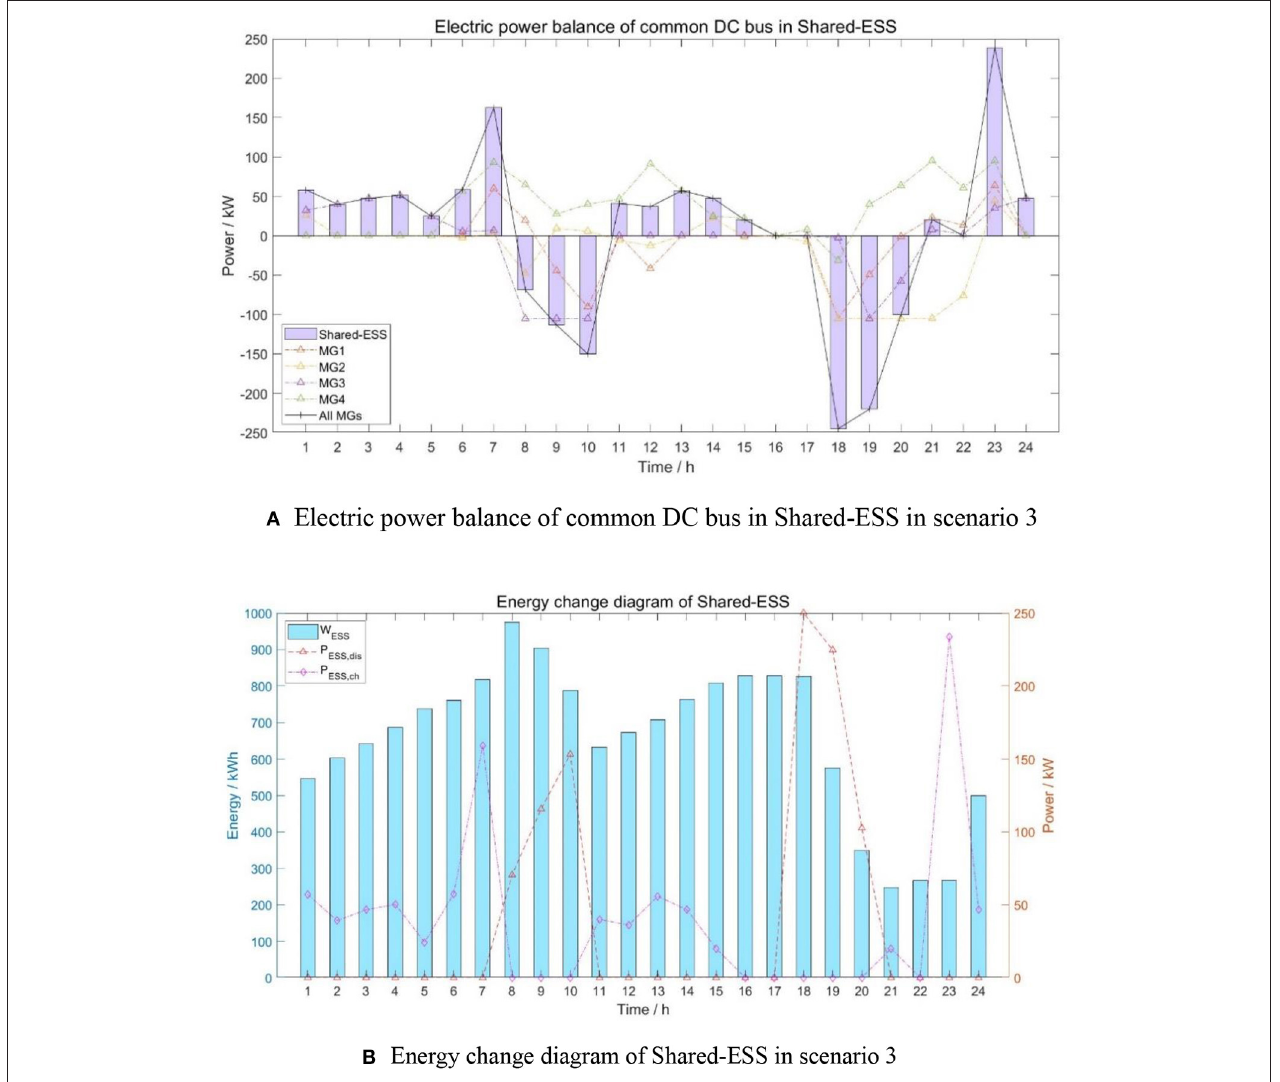
FIGURE 7 | The operating status of Shared-ESS in scenario 3. (A) Electric power balance of common DC bus in Shared-ESS in scenario 3. (B) Energy change diagram of Shared-ESS in scenario 3.